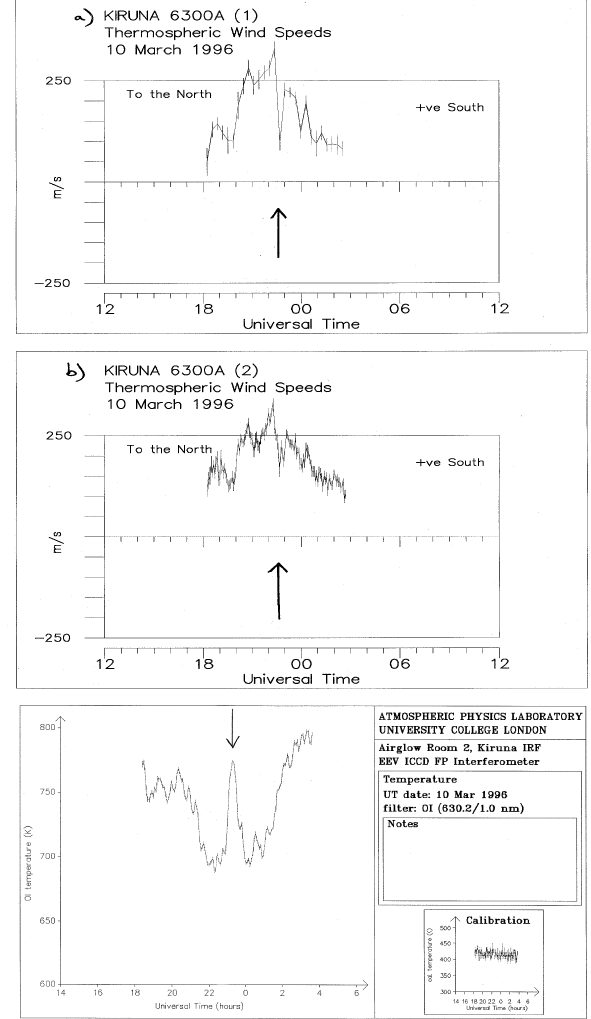
Fig. 9. Comparison of the meridional component of thermospheric winds measured on the 10 th March 1996 at Kiruna with a FPI using (a) an Imaging Photon Detector (IPD) which has an integration time of 120 seconds and (b) an Intensified CCD detector (ICCD) which requires only a 15 second integration time. Note the sharp drop and rise in wind speed between 2200UT and 2300UT. Only one data point marks this in (a) and the datum may have been disregarded as an outlier, however, the high time resolution of the ICCD shows in Fig. 9b that this is a real feature. (c) Thermospheric temperatures measured using the new ICCD detector show a rapid rise and fall in temperature between 2200UT and 2300UT that corresponds with the rapid drop and rise in wind speed shown in (a) and